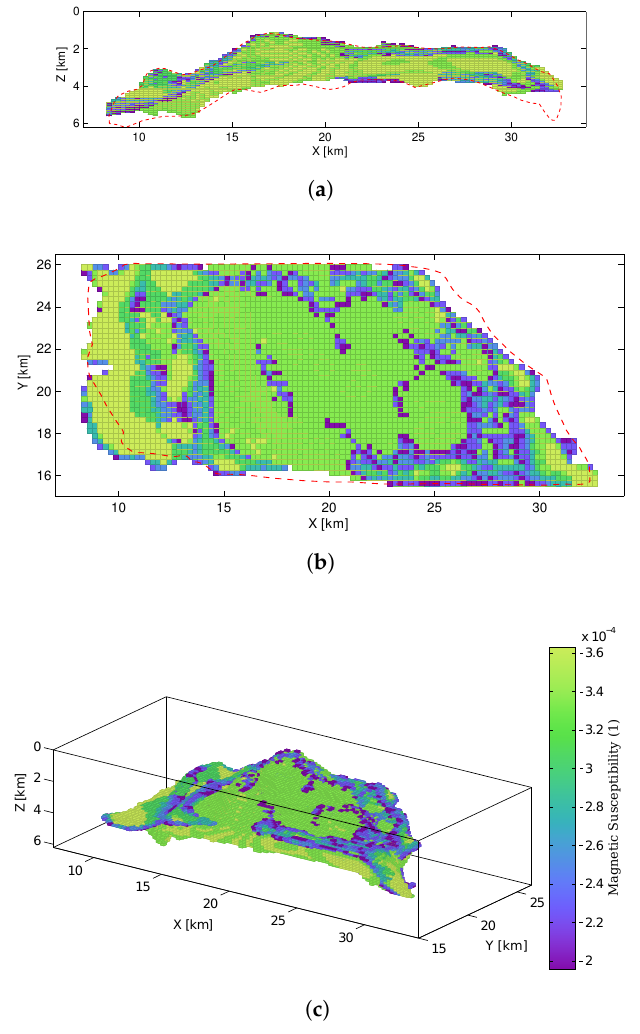
Figure 31. Inverted magnetic model for the salt body. ( a ) XZ view. The red dotted line represents the limits of the real model (Figures 7 and 8). ( b ) XY view. The red dotted line represents the limits of the real model (Figures 7 and 8). ( c ) Three-dimensional